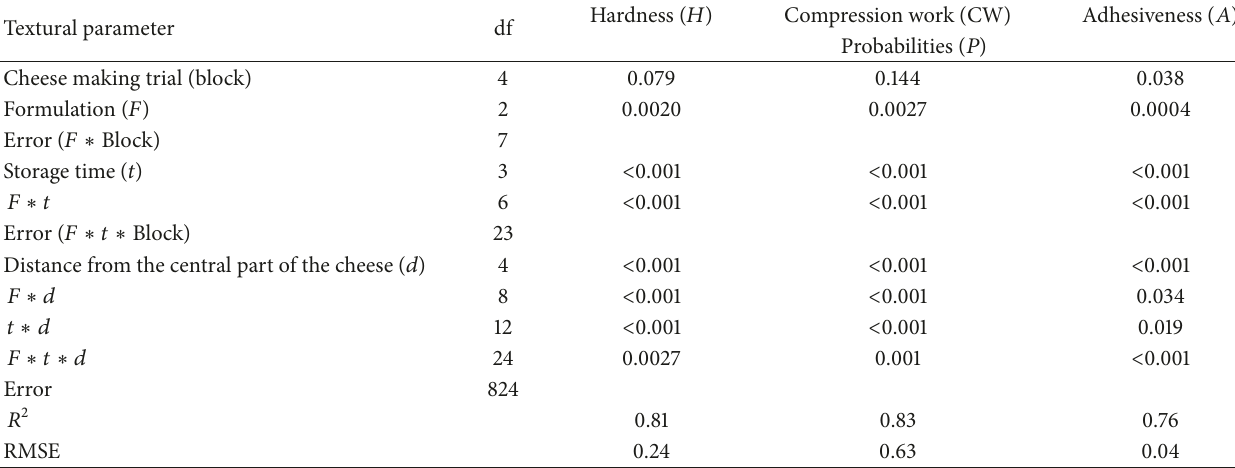
Table 2: Effect cheese formulation (𝐹) , storage time (𝑡) , distance from the central part of the cheese (𝑑) , and their interactions on the textural properties of Crescenza